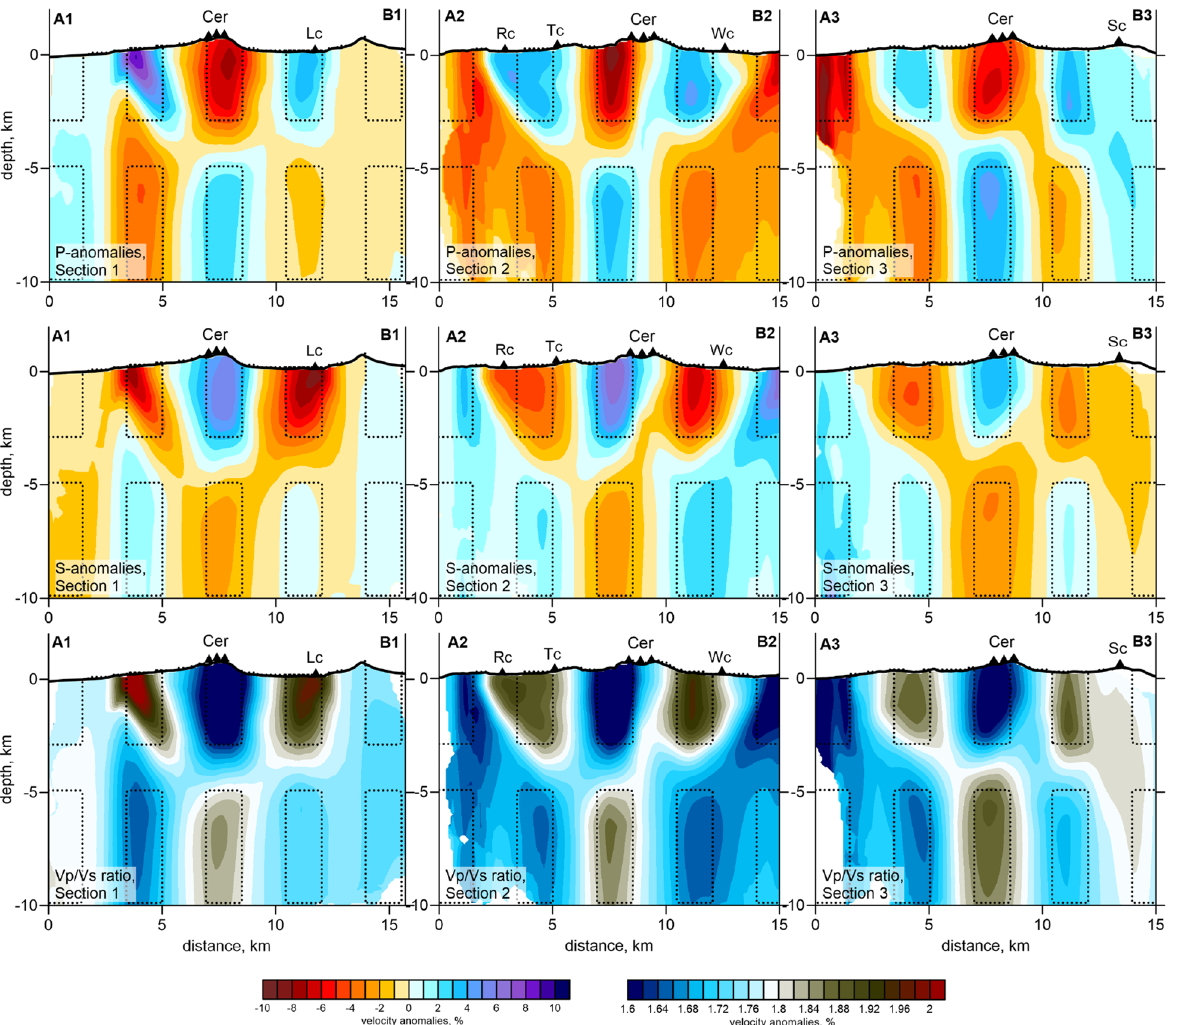
Figure 4. Resulting distributions of d Vp , d Vs , and Vp / Vs ratios after the recovery of three synthetic models defined along three vertical sections (the same as those used to present the main results in Figs. 6 and 7). The synthetic anomalies are indicated by the dashed lines. The projections of the main volcanic vents are shown as black triangles. Cer cerberus stratovolcano, RC ringworm cone, Tc threequarter cone, Wc windy cone, Lc lakeshore cone, Sc sugarloaf cones. The figure was generated using the software Surfer (version 13, http:// www. golde nsofw are. com/ produ cts/ narrow anomalies separated by large interval of zero values, we observe some smearing, when the transitions between anomalies appear to be smooth. Similar effect might exist in the case of the experimental data inversion. The synthetic tests provided the opportunity to estimate the accuracy of the source locations. During the recovery procedure, the true source locations were presumed to be unknown; therefore, the difference between the final and true locations provided an adequate image of the real uncertainty of the source locations during the experimental data inversion. An example of source mislocations for the vertical checkerboard along Sect. 3 (shown in the right-hand column of Fig. 4) is presented in Fig. 5. After locations in the starting 1D model, the mean error was 0.65 km; however, after five iterations of the simultaneous inversions of the source and velocity parameters, the error was reduced to 0.47 km. As expected, the uncertainty of the source depth locations was larger than that of the horizontal coordinates. Note that despite such significant errors and outliers, the velocity model was correctly recovered. The results of the experimental data inversion are presented in Figs. 6 and 7 in four horizontal and three vertical sections with the Vp and Vs anomalies and the Vp / Vs ratios, which were calculated by the division of the resulting absolute P - and S -wave velocities. The stability of this method for calculating Vp / Vs was confirmed by the series of synthetic tests described above. The final locations of the sources of this velocity model are shown in map view and vertical sections in Fig. 2.